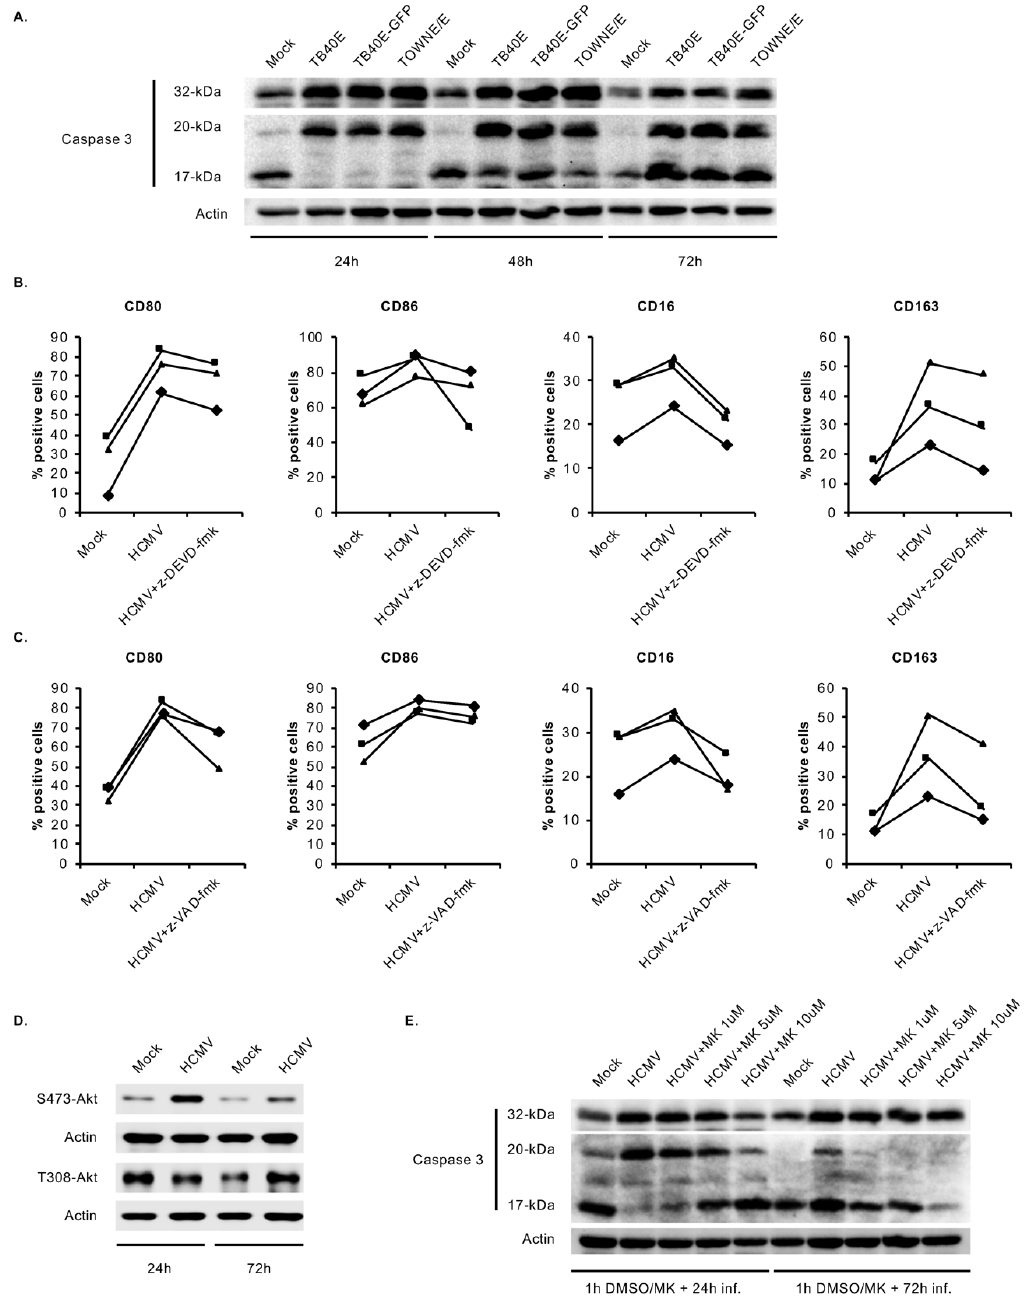
Figure 5. HCMV-induced caspase 3 activation after the 48-h viability gate mediates the unique monocyte-to-macrophage di ff erentiation. ( A ) Human peripheral blood monocytes were mock- or HCMV-infected with TB40E, TB40E-GFP or TOWNE / E for 24, 48, or 72 h. Levels of pro-caspase 3 (32 kDa), intermediate caspase 3 (20 kDa), fully active caspase 3 (17 kDa), and actin were detected by immunoblotting from whole cell lysates. ( B , C ) Monocytes were pretreated for 1 h with a vehicle control, ( B ) a caspase 3 inhibitor (z-DEVD-fmk) at 20 µ M, or ( C ) a pan-caspase inhibitor (z-VAD-fmk) at 50 µ M. Cells were then mock- or HCMV-infected for 48 h and the percent positive cells for M1 (CD80 and CD86) and M2 macrophage markers (CD16 and CD163) were measured by flow cytometry. ( D ) Monocytes were mock- or HCMV-infected for 24 or 72 h. Levels of S473-Akt, T308-Akt, and actin were detected by immunoblotting. ( E ) Monocytes were pretreated for 1 h with MK at 1, 5, or 10 µ M, or vehicle control and then mock- or HCMV-infected for 24 h or 72 h. Levels of pro-caspase 3 (32 kDa), intermediate caspase 3 (20 kDa), fully active caspase 3 (17 kDa), and actin were detected by immunoblotting. ( A – E ) Results are representative of 3–6 independent experiments using monocytes from di ff erent